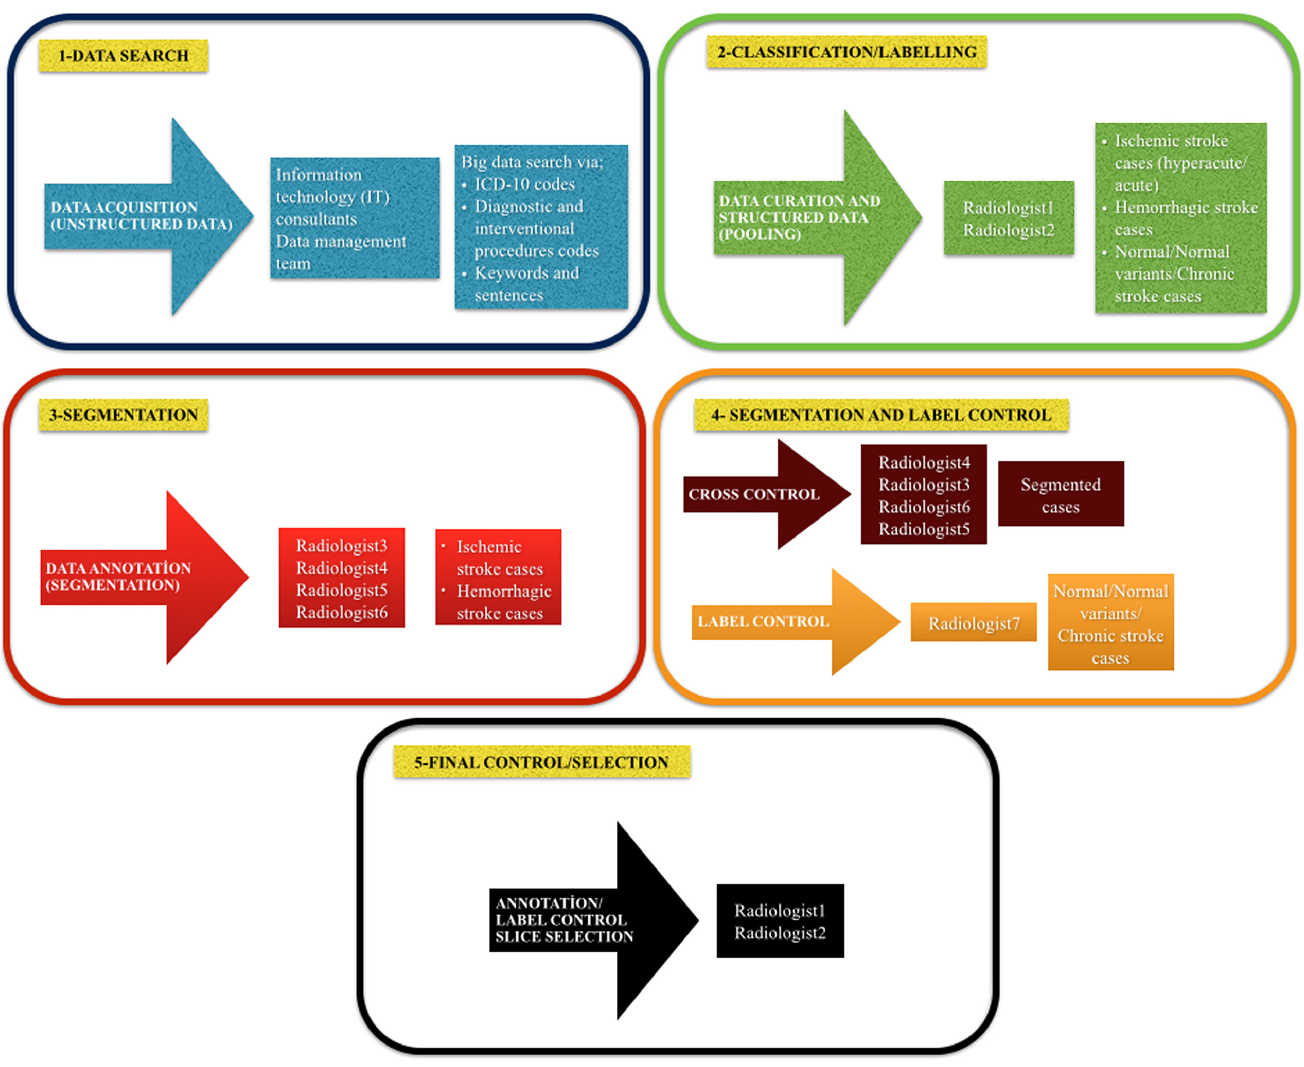
Figure 3. Radiologist task sharing and data set annotation methodology.